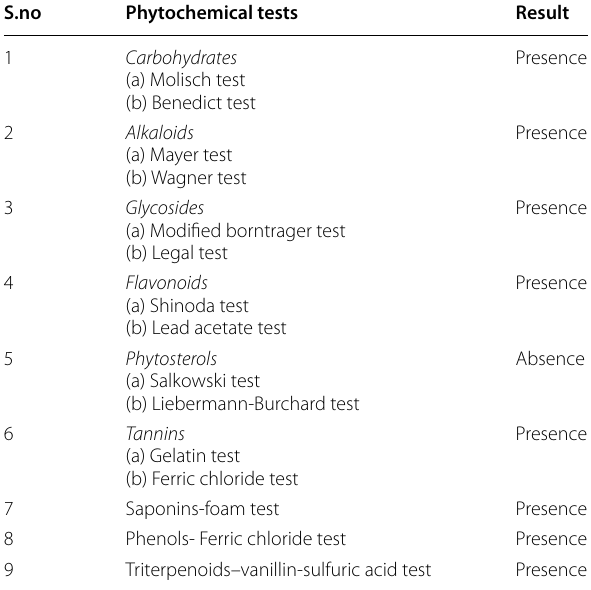
Table 2 Preliminary phytochemical screening tests of Luffa cylindrica (Linn)